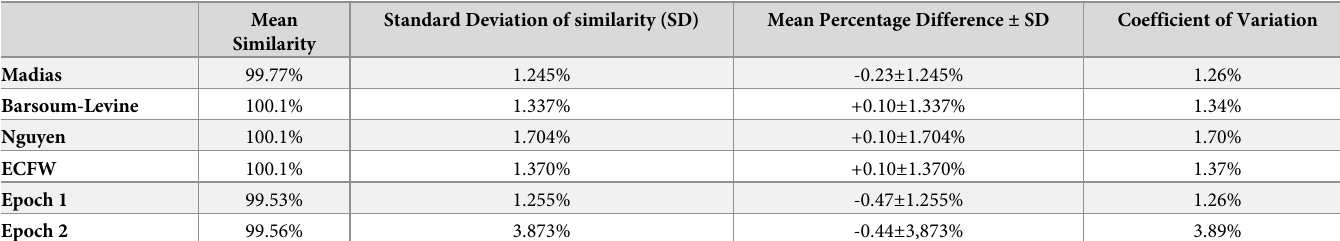
Table 1. Comparison of the predictive power of our equation with other existing formulae with the statistical model of the percentage similarity.